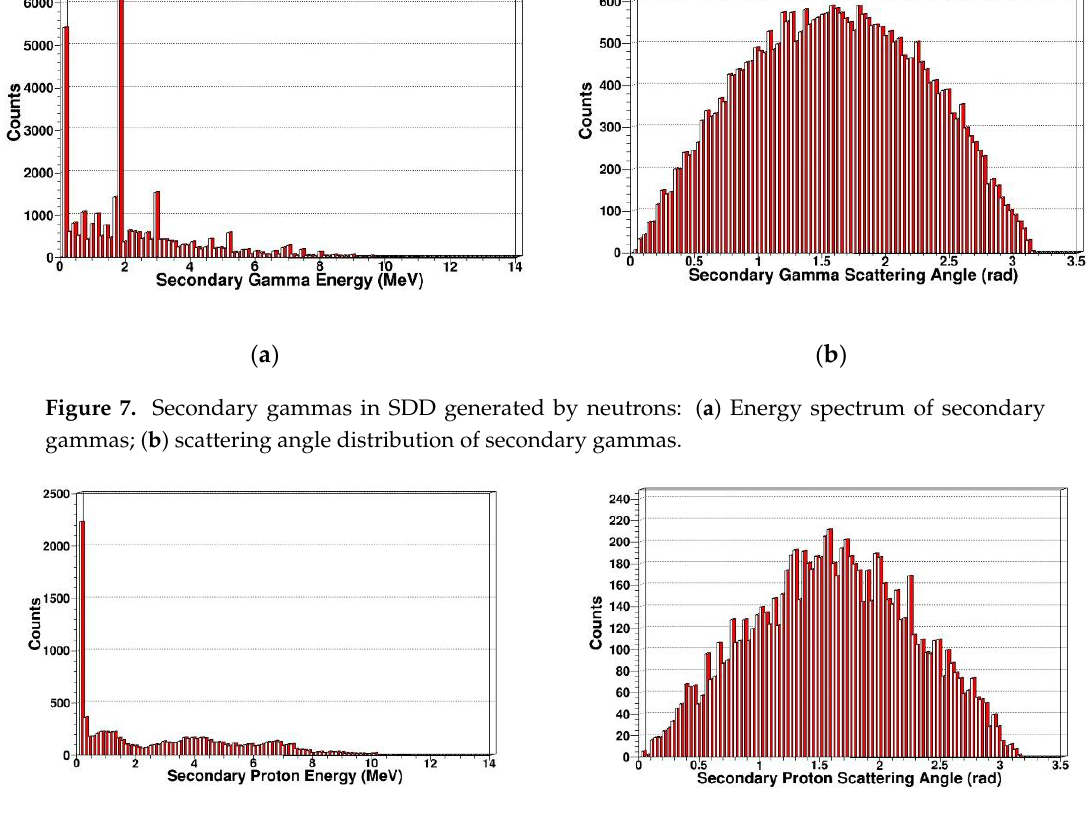
Figure 7. Secondary gammas in SDD generated by neutrons: ( a ) Energy spectrum of secondary gammas; ( b ) scattering angle distribution of secondary gammas.